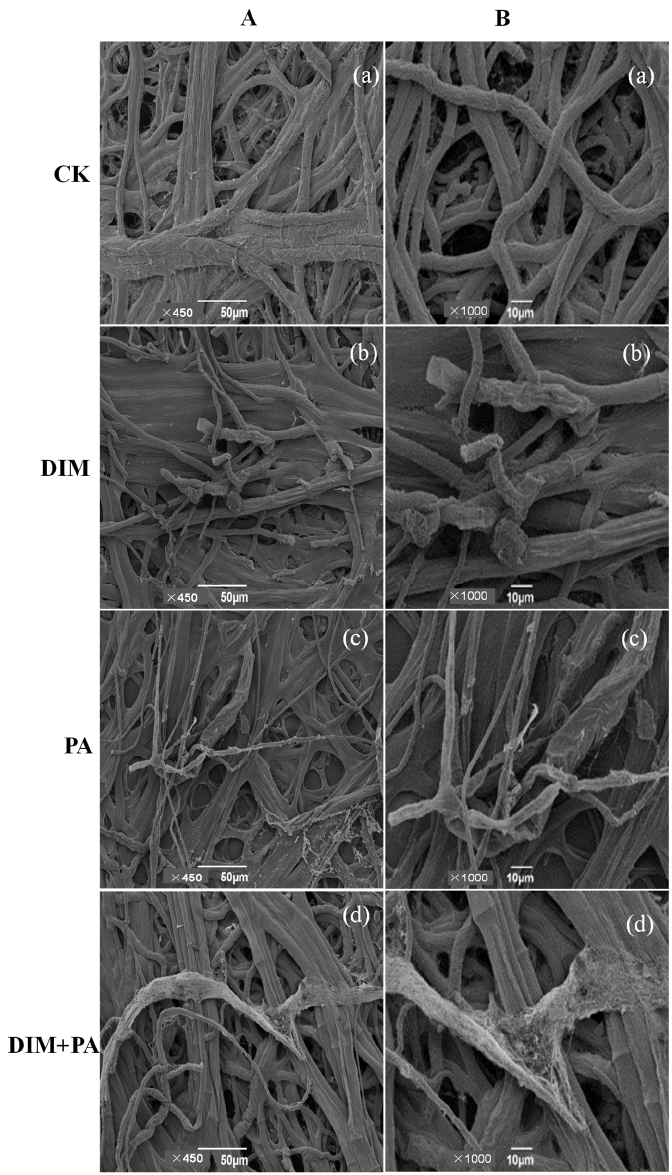
Figure 4. Effect of DIM or PA treatments on structural appearance changes of sclerotia. Scanning electron microscope (SEM) images of mycelia in S. sclerotiorum receiving DIM or PA. ( A : bars = 50 μ m, ×450; B : bars = 10 μ m, ×1000). The treatments were: ( a ): CK, ( b ): DIM (0.8 mg·L − 1 ), ( c ): PA (0.1 mg·mL − 1 ), and ( d ): DIM (0.8 mg·L − 1 ) + PA (0.1 mg·mL − 1 ), respectively.